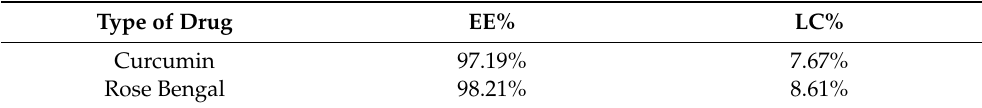
Table 2. Encapsulation efficiency and loading capacity for curcumin and Rose Bengal co-encapsulated inside the